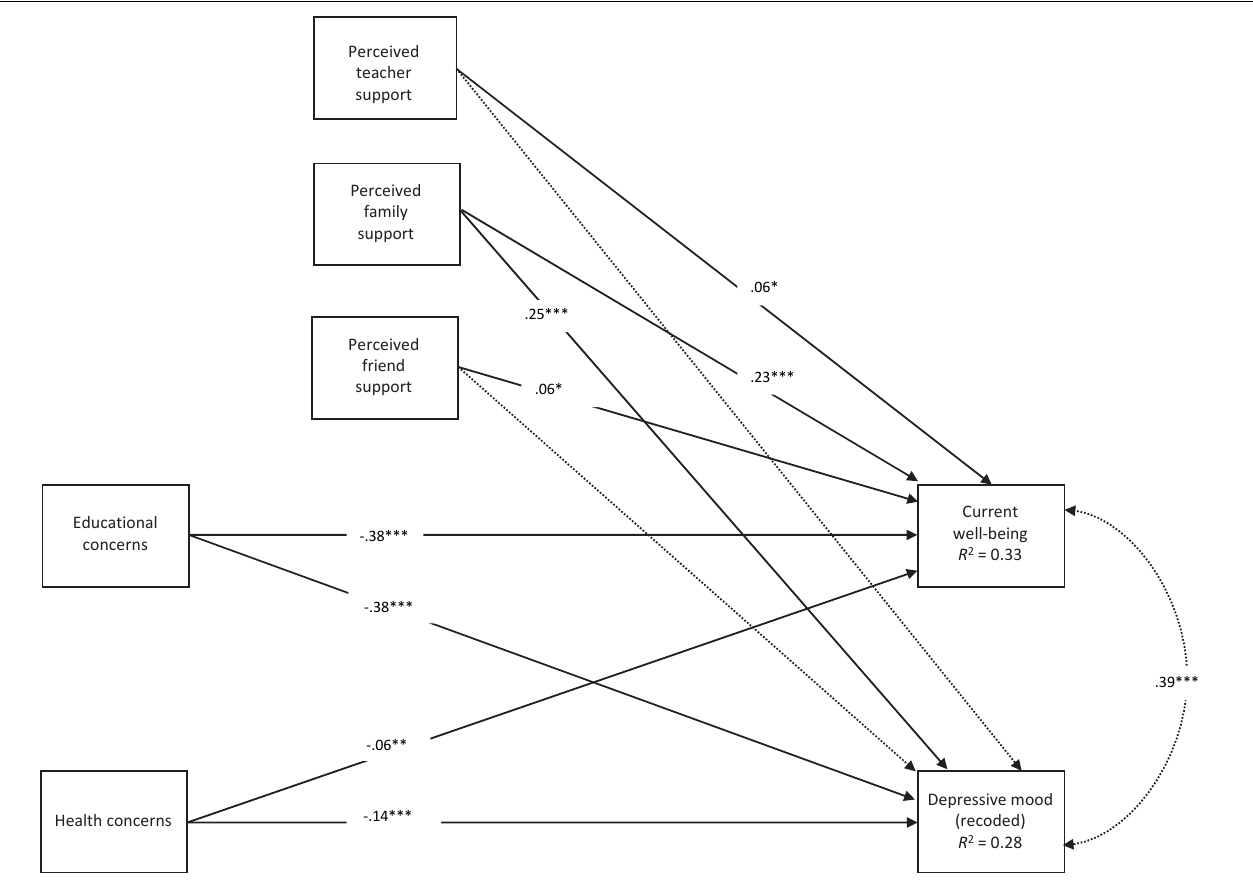
FIGURE 2 | Path analysis predicting adolescents’ current well-being and depressive mood with the two risk (i.e., educational and health concerns) and three protective factors (i.e., perceived social support by teachers, family, and friends). Depressive mood was recoded, with higher values reflecting lower depressive mood. Standardized estimates are reported on the straight and curved arrows. The dashed arrows represent non-significant paths. ∗ p < 0.05, ∗∗ p < 0.01, ∗∗∗ p < 0.001, two-tailed.